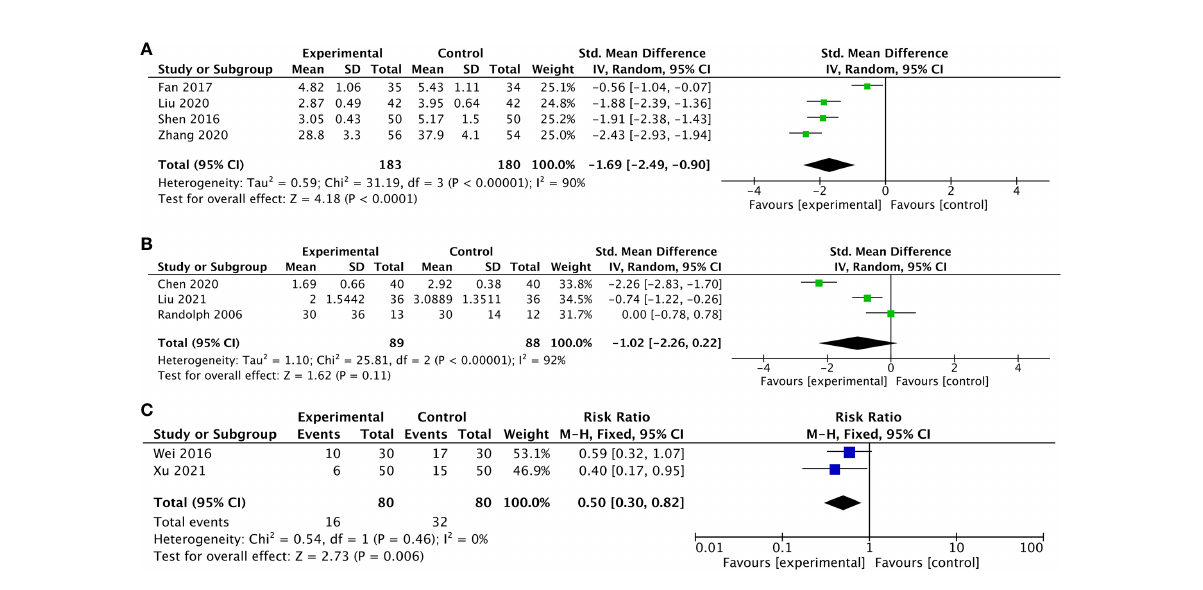
FIGURE 3 Forest plot of the pain in lung cancer patients treated with acupuncture and control. (A) The changes measured by the combination of the Numerical Rating Scale (NRS) score and Visual Analog Scale (VAS) pain scales in lung cancer patients with cancer pain treated with acupuncture-related intervention versus control from the baseline to the end of treatment; (B) the changes measured by the combination of NRS and VAS scores in lung cancer patients undergoing surgery treated with acupuncture-related intervention versus control from the baseline to the end of treatment; (C) the changes measured by the combination of the NRS score in lung cancer patients with cancer pain treated with acupuncture-related intervention versus control from the baseline to the end of treatment using dichotomous variables. IV, inverse variance; CI, con fi dence interval.